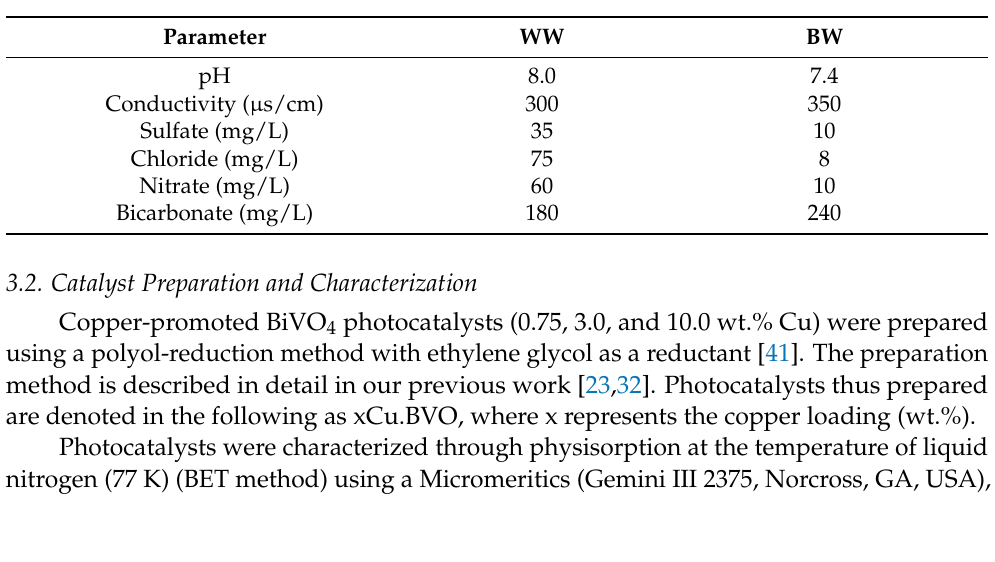
Table 3. Real water matrices’ characteristics.